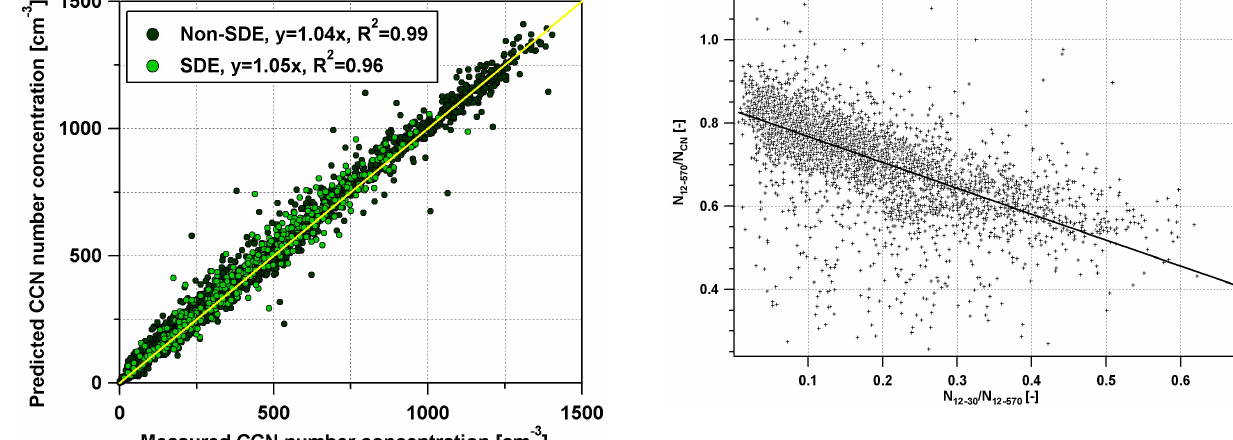
Fig. A1. The ratio between the integrated SMPS concentration ( N 12 − 570 ) and the total concentration ( N CN ) as a function of the fraction of small particles. The black line represents the linear fit through the data